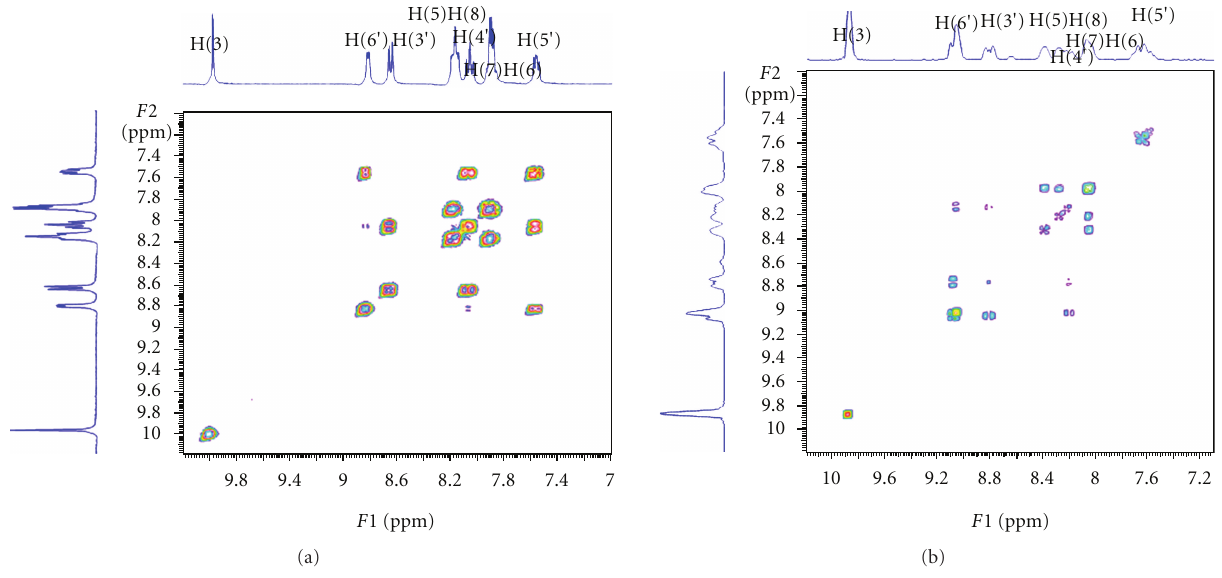
Figure 2: COSY-NMR spectra of pq (a) and [ReOCl 3 pq] (b) in